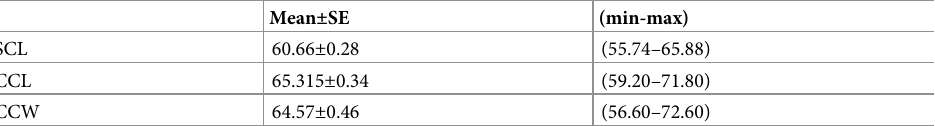
Table 1. Morphometric data (cm) of L . kempii turtles from Rancho Nuevo, Tamaulipas, Mexico, 2018–2020.